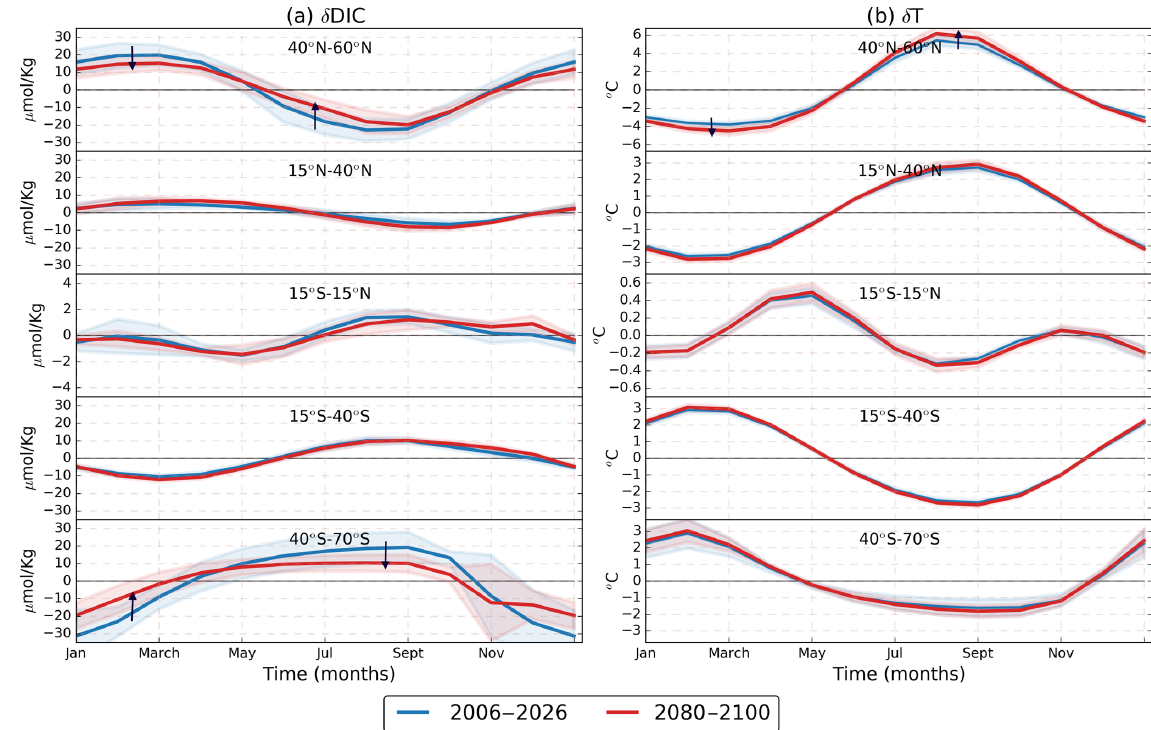
Figure 5. RCP8.5 ensemble zonal mean seasonal cycles of (a) δ DIC s and (b) δT for different latitudinal bands. Blue lines represent the 2006–2026 period, depicted for comparison with the 2080–2100 period shown by red lines. Different panels represent different latitudinal sections. Black arrows point out that while the T seasonal cycle is projected to increase in most of the ocean, global DIC s is projected to decrease. The shading represents 1 standard deviation across the models. It is important to note that the scale is different for some of the latitudinal